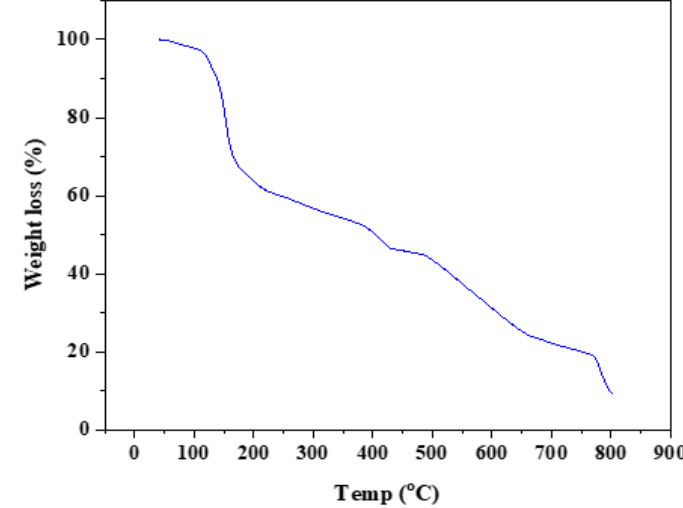
Figure 2. TGA curve of [Cu(L)(bpy)] 1g complex.